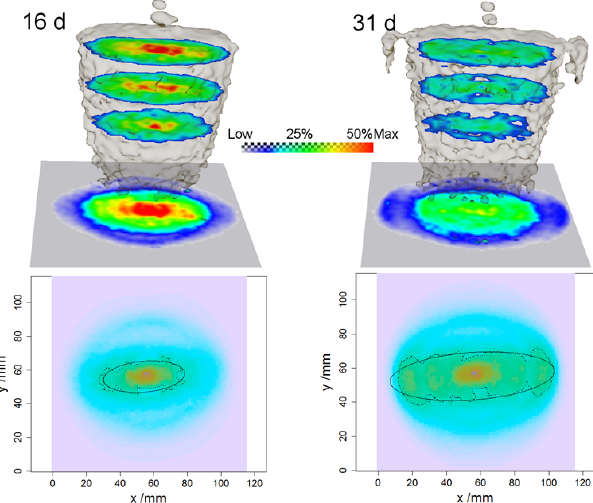
Figure 12. Top: horizontal slices and axial projection of the tracer concentration tomograms during diffusion of 22 Na into Opalinus Clay, after 13 and 27 days. Bottom: axial projections with fitted FWHM ellipsoids (full width half maximum). Deviations from the elliptical shape indicate heterogeneous effects that are not consid- ered as homogeneous anisotropy (Kulenkampff et al.,